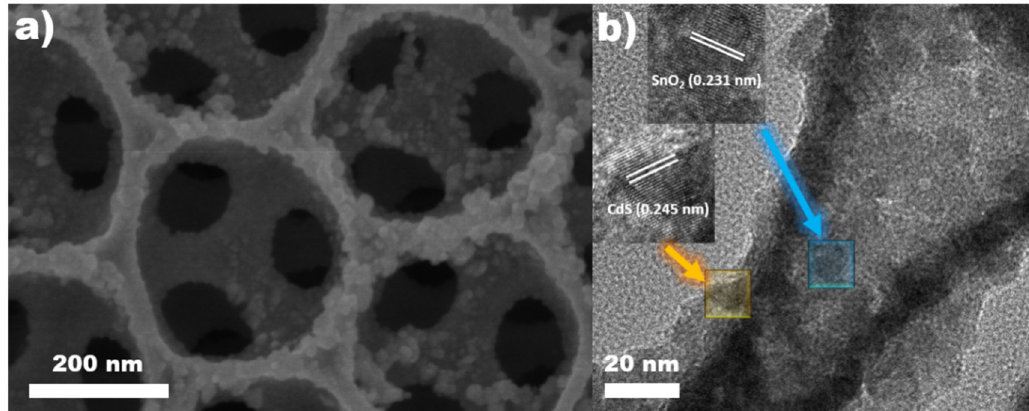
Figure 3. ( a ) TEM image of CdS/PC FTO and ( b ) HR-TEM of CdS/PC FTO; the lattice fringes correspond to JCPDS numbers of 64-3414 (CdS) and 41-1445 (SnO 2 ), respectively.